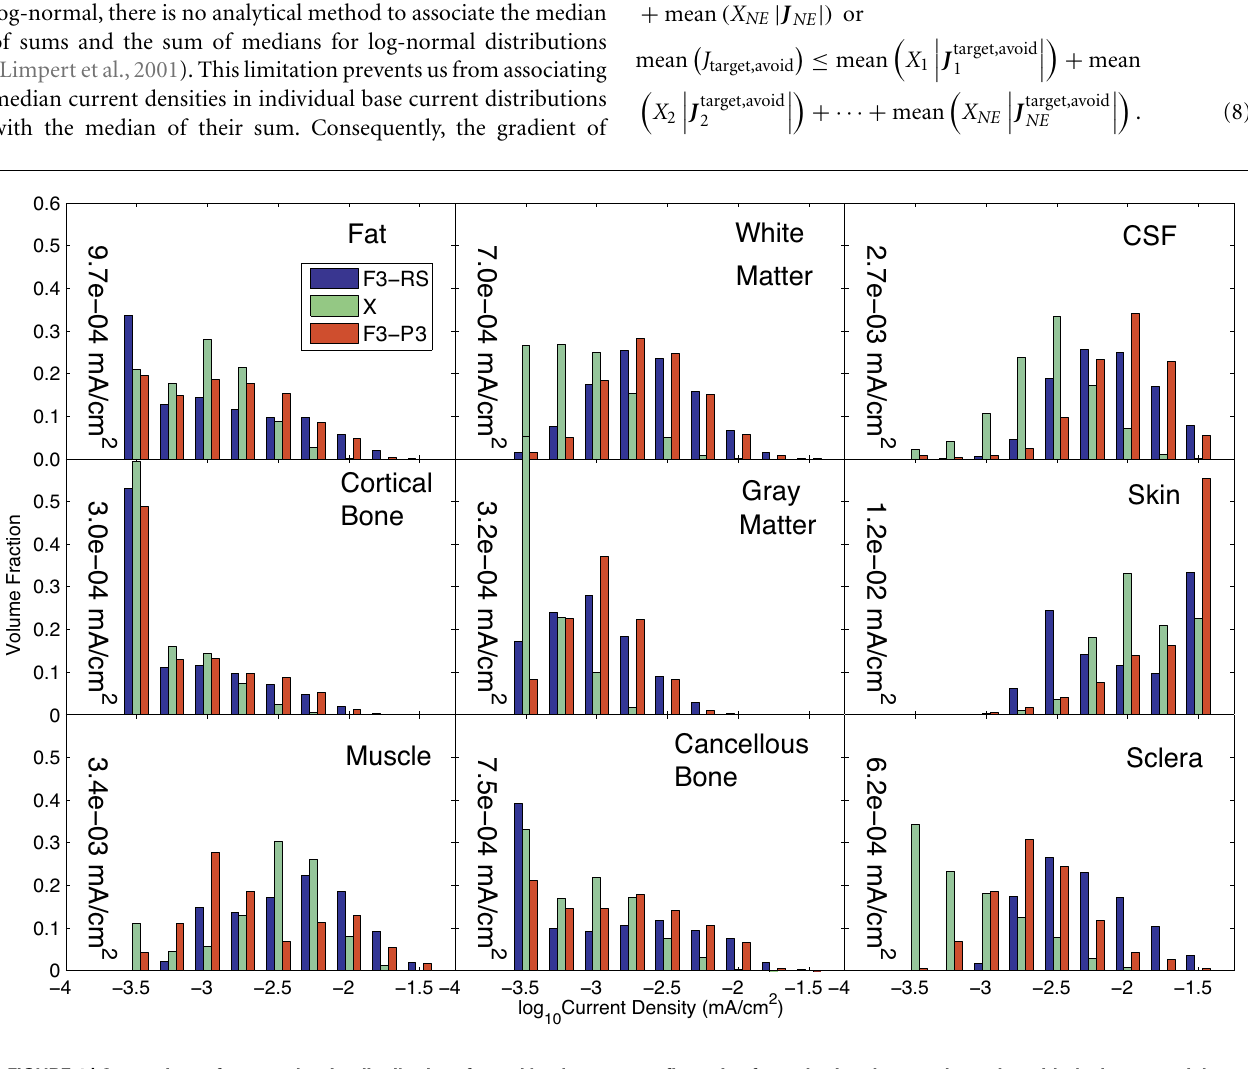
FIGURE 4 | Comparison of current density distributions formed by three candidate current patterns (the optimal solution to Problem 1, X; a configuration previously used in the literature (F3-RS); and a